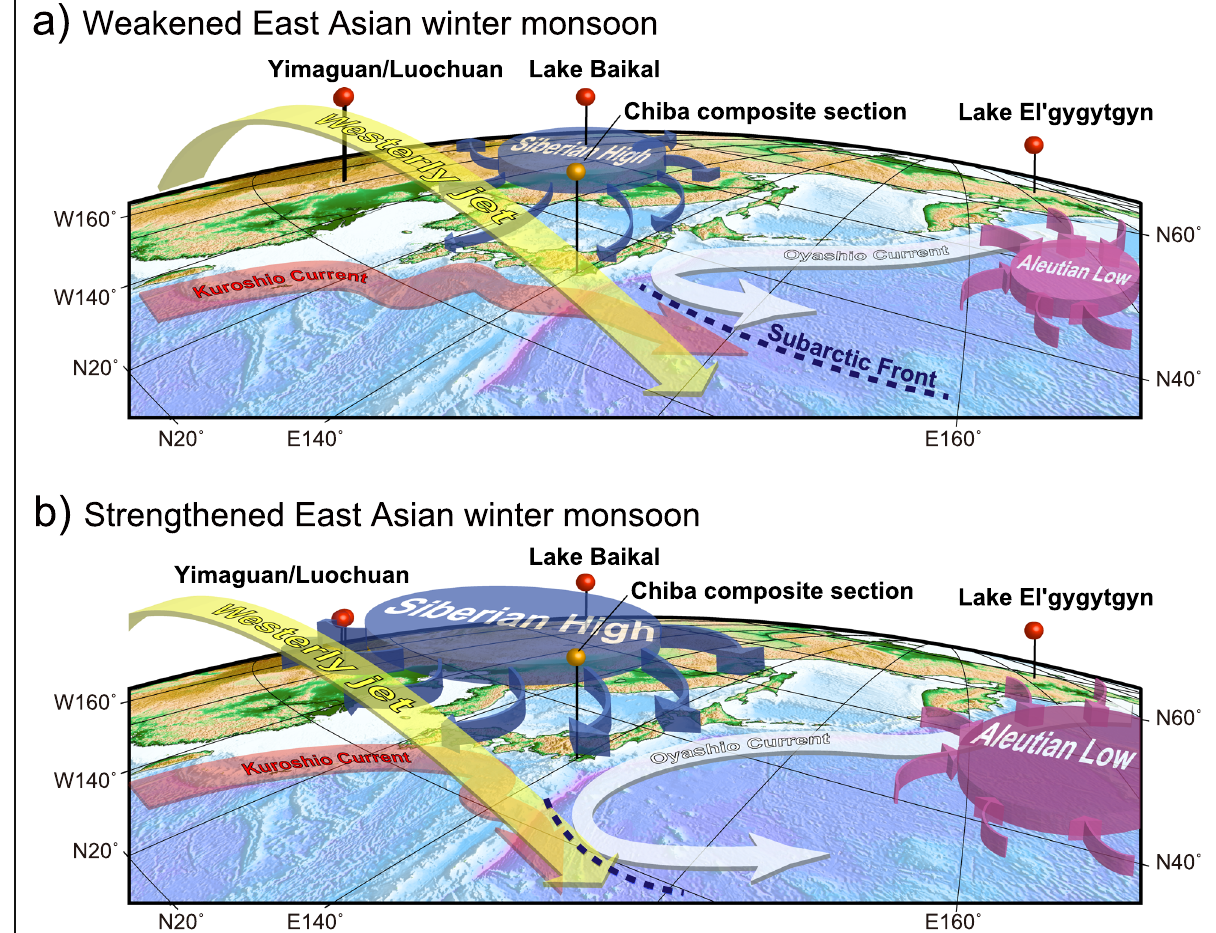
Fig. 17 A schematic representation of the northwest Pacific showing the north/south migration of the westerly jet in winter and associated shifts of the Subarctic Front. A weaker east Asian winter monsoon (EAWM) ( a ) causes the Subarctic Front to move northwards (interstadial conditions), and a stronger EAWM ( b ) deflects it southwards (stadials). The EAWM is controlled by the thermal contrast between the Siberian High and Aleutian Low atmospheric pressure systems: when both are intensified ( b ), the EAWM is strongest. Locations of sites discussed in the text are shown. Adapted from fig. 15 of Suganuma et al.